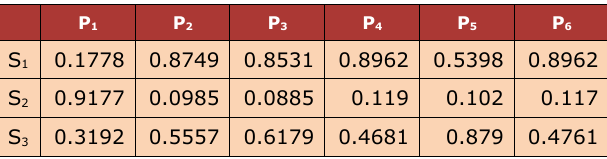
Table 6. Matrix of